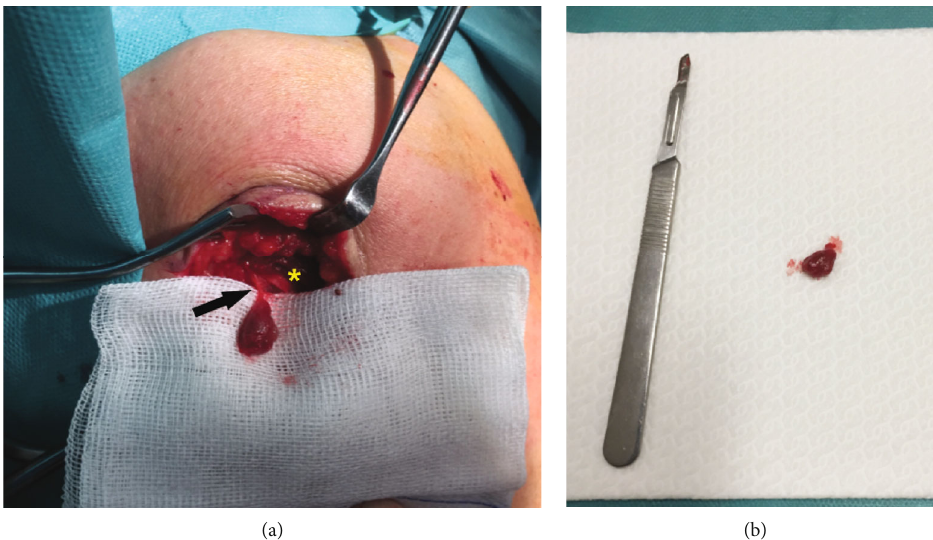
Figure 4: Intraoperative images. (a) Isolated tumor, primarily found in the substance of the deltoid muscle (yellow asterisk), with the tumor pedicle still intact (black arrow). (b) Resected lesion (125mm scalpel handle with n ° 11 blade for